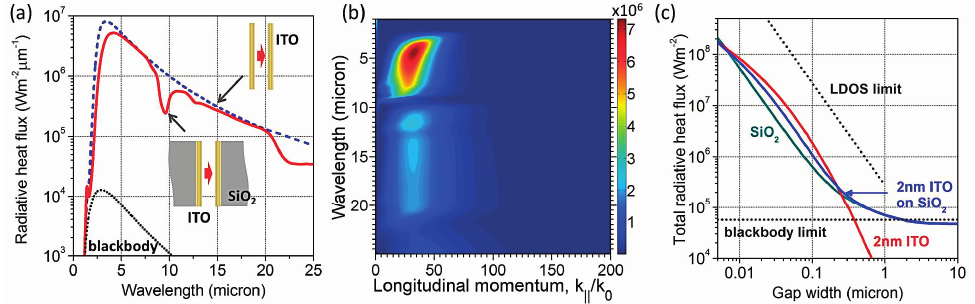
Figure 6. ( a ) The heat flux spectra as a function of wavelength between 2 nm-thin suspended ITO films (blue dashed line) and 2nm-thin ITO films supported by SiO 2 substrates (red solid line). The emitter and absorber are separated by a 20 nm gap. ( b ) Transmission coefficients from Equation (2) as a function of wavelength and the normalized parallel wave vector for ITO films on SiO 2 substrate. ( c ) Total integrated heat flux between 2 nm-thin suspended ITO films (red solid line), 2 nm-thin ITO films supported by SiO 2 substrates (blue solid line), and bulk SiO 2 substrates (teal solid line). The maximum possible total heat flux across the gap (LDOS limit) and the blackbody limit are shown for comparison (gray dotted lines). The hot and cold side temperatures are 1000 K and 300